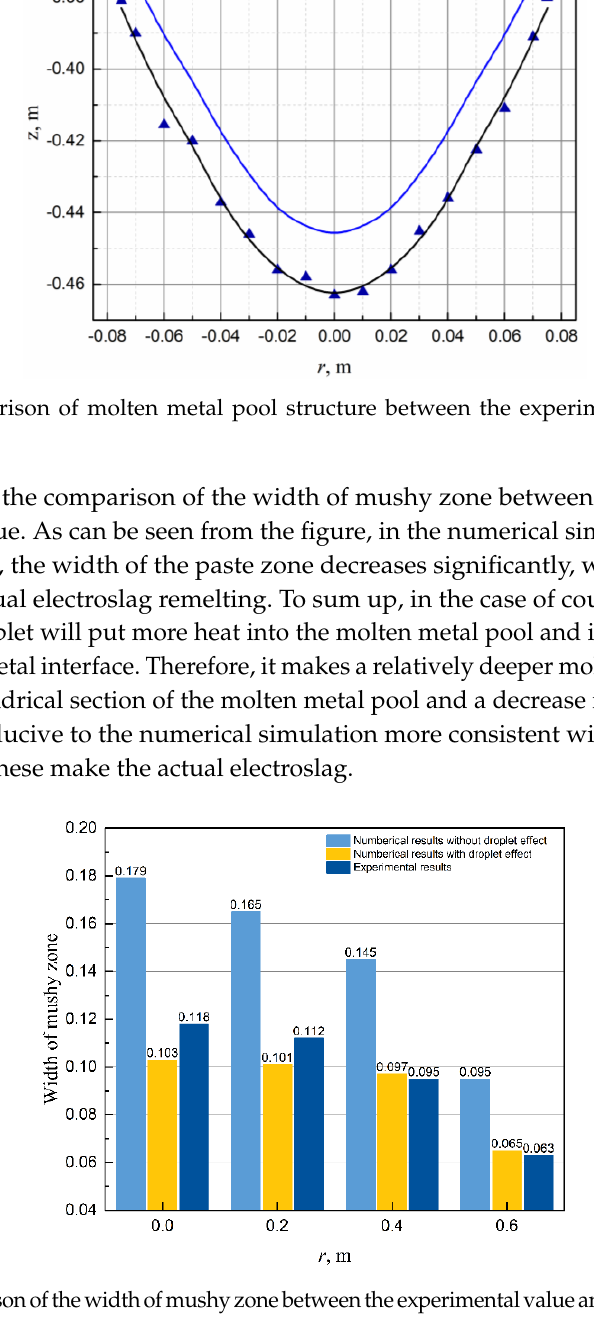
Figure 20. The experiment of TSCE-ESR process. ( a ) Photo of the TSCE-ESR plant experiment. ( b ) Molten metal pool structure in the process of TSCE-ESR.